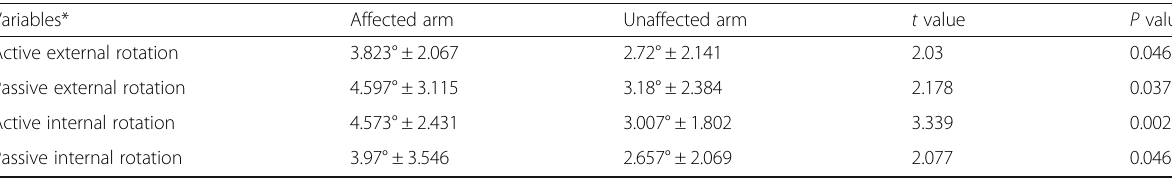
Table 2 Comparison of angular displacement errors of shoulder joint position sense in affected arm and unaffected arm of patients (G1)